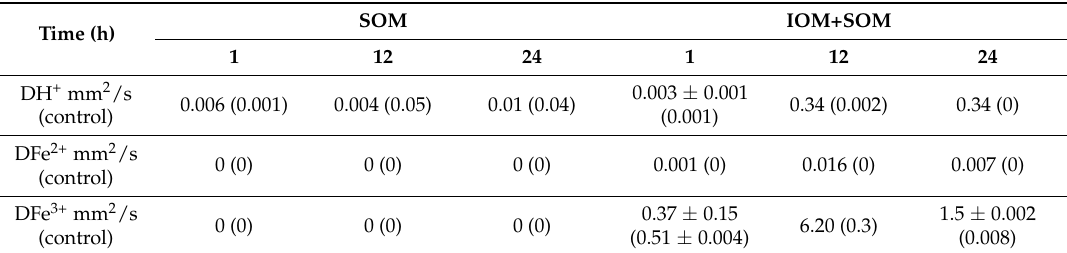
Table 2. Diffusivity values (D) for soluble H + , Fe 2+ and Fe 3+ (Equation (1)) of assays with MCE*-S 0 subjected to SOM or SOM+IOM activity and their corresponding abiotic control. Data: Average ( n = 3) ± standard